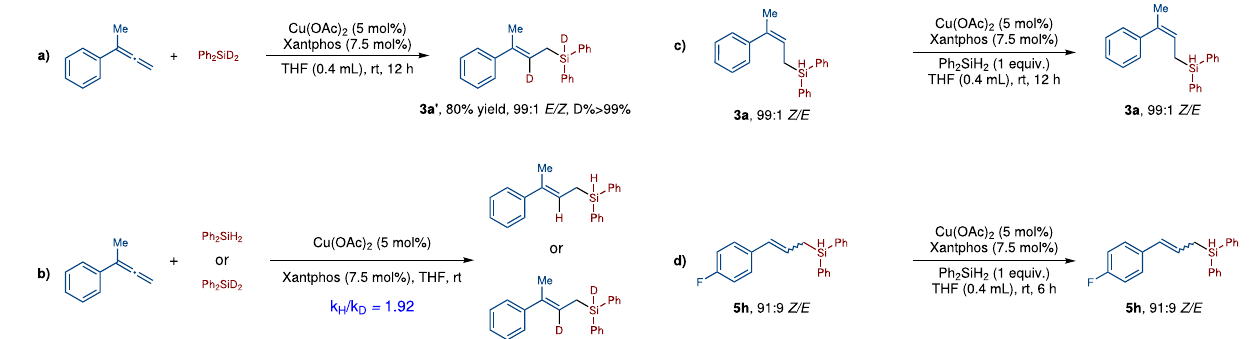
Fig. 5 Mechanism study. a A deuterium-labeling reaction indicate that the hydrogen comes from the silane. b KIE study suggested that the rate- determining step might involve in the reaction of Si-H bond. c No isomerization of Z -3a to E -3a suggest that the selectivity is kinetically controlled. d No change of the Z/E ratio of 5 h suggest that our Cu-catalyzed reaction is kinetically controlled.